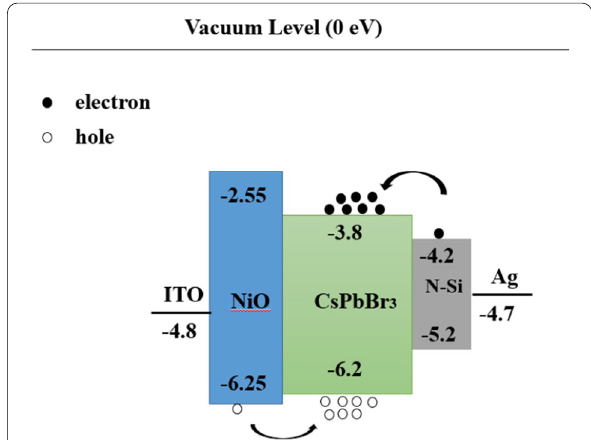
Fig. 11 The working mechanism of the PeLEDs based on the energy band